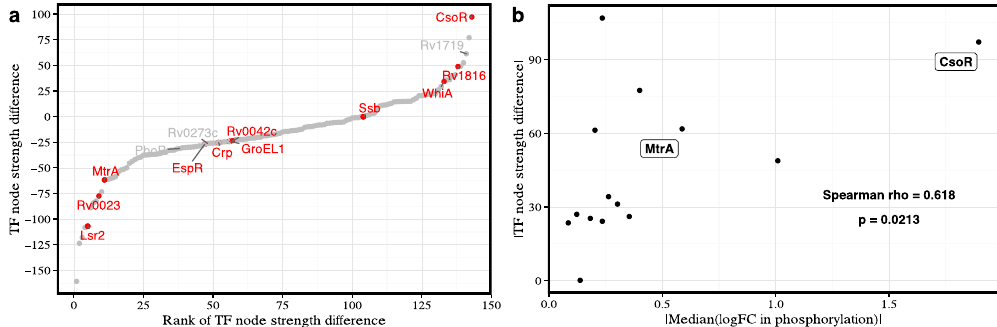
Fig. 3 Change in transcription factor phosphorylation is correlated with change in node strength. a The difference in node strength ( y - axis) and rank of difference in node strength ( x -axis) are shown for the 143 transcription factors included in the regulatory network model. Of those, 14 TFs had detected phosphopeptides and 11 were differentially phosphorylated (adj. P < 0.05, shown in red). b The magnitude of change in TF node strength between active and control kinase inhibitor networks correlates with change in phosphorylation (Spearman correlation, ρ s = 0.618 and P = 0.0213). The median log2 fold change was used when multiple phosphopeptides were detected for the same